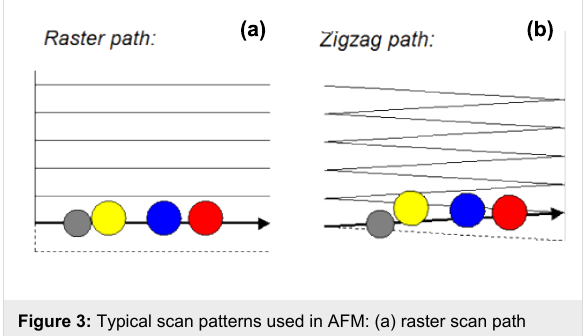
Figure 2: Typical trajectories of bare gold nanoparticles (20 nm diam- eter) on a silicon substrate when the probing tip moves along a zigzag path: (a) low drive amplitude, (b) high drive amplitude. Scan size: 5 µm.